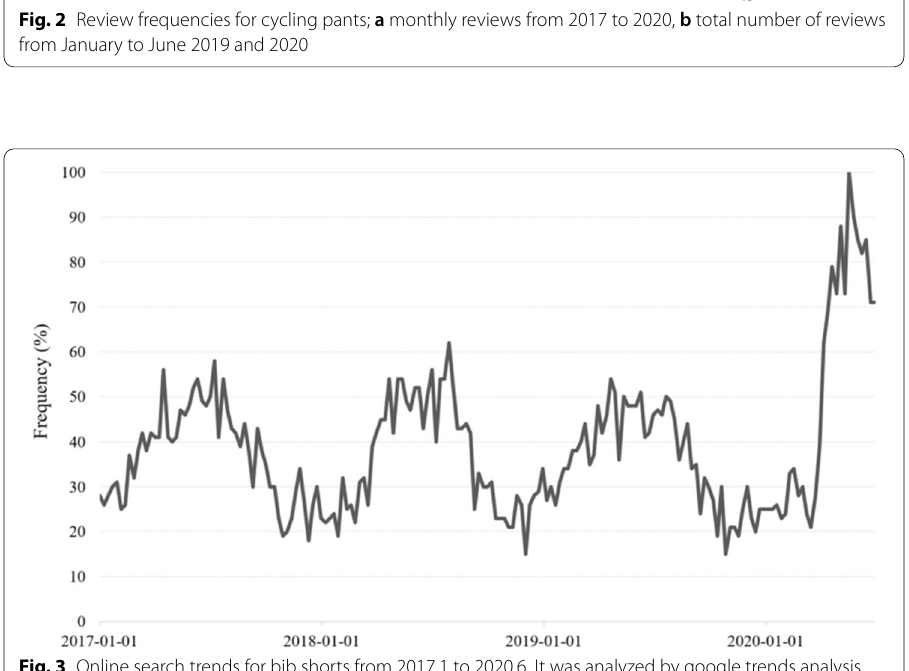
Fig. 3 Online search trends for bib shorts from 2017.1 to 2020.6. It was analyzed by google trends analysis at https:// trends. google. com. The frequency value appears as 100 for the search term with the highest frequency, 50 for the search term with half the frequency, and 0 if there is not enough data for the search